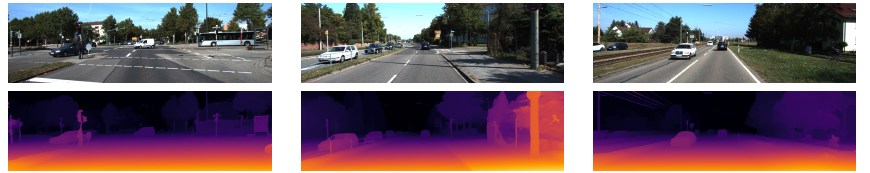
Figure 2. The qualitative results from [26] show the left RGB images from 3 scenes in the KITTI-2015 stereo dataset in the top row and the corresponding disparity map predictions in the bottom row are shown using colour to represent the disparity